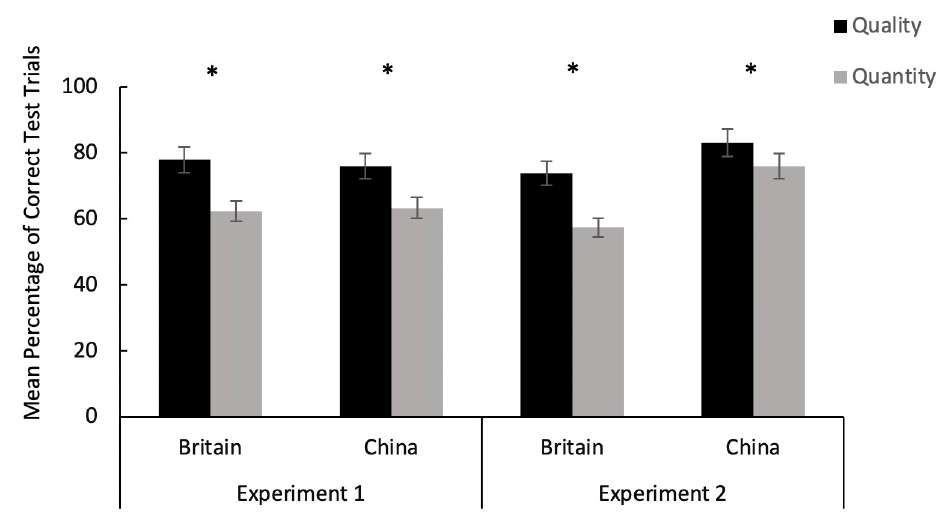
Fig 3. Mean percentage of correct test trials across age groups by condition (quality and quantity) in Experiment 1 & 2. � indicates performance above chance level (p < 0.05), error bars indicate standard errors. Data on the British children has been published in Miller et al. [52].